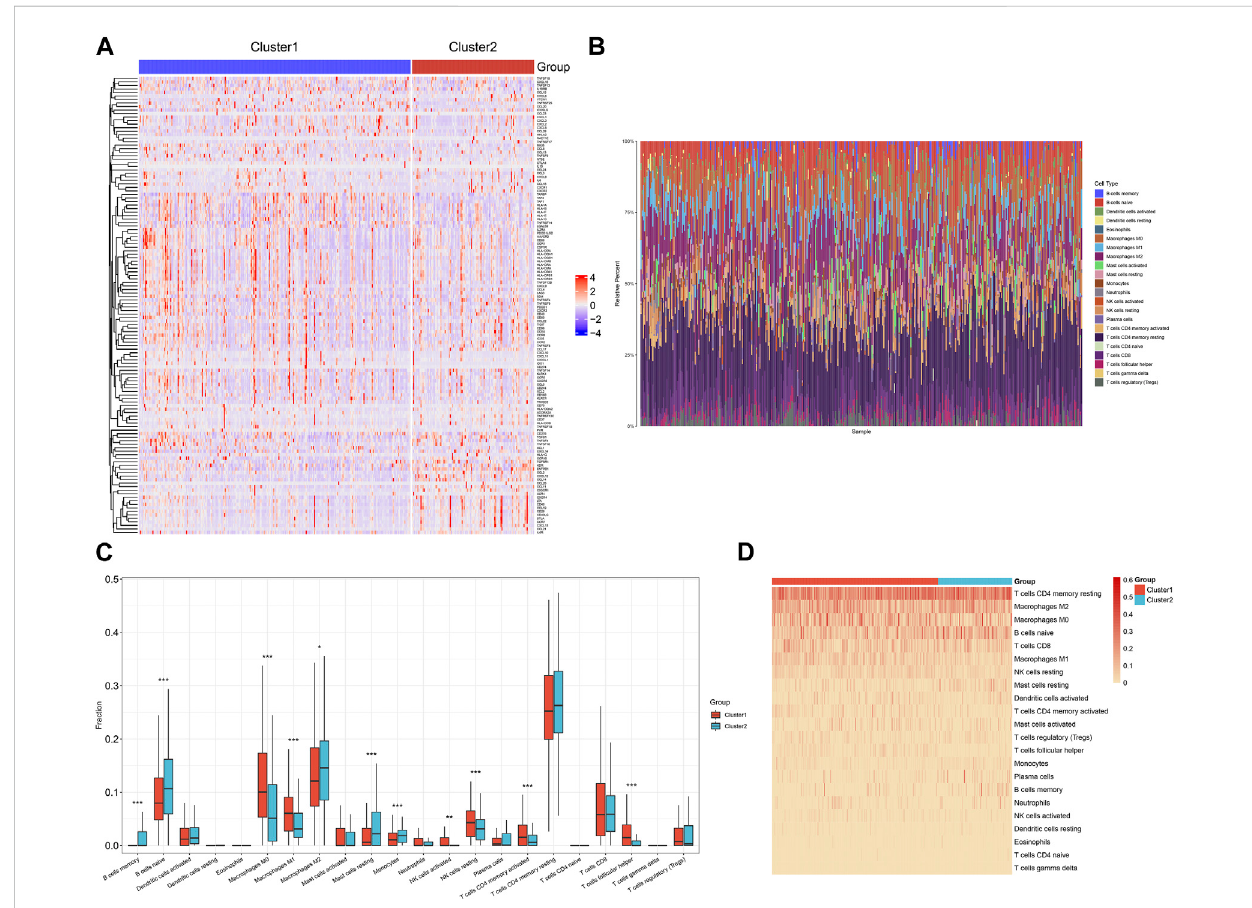
FIGURE 3 Tumor microenvironment heterogeneity across the two DNA damage repair-based subtypes in the TCGA-STAD cohort. (A) The transcriptional levels of immunomodulators across the two subtypes. Colors from blue to red denote low to high expression values of immunomodulators. (B) Landscape of the relative fractions of 22 immune cell types across TCGA-STAD. Each cell type is marked by unique color. (C) Comparison of the relative fractions of 22 immune cell types between subtypes. (D) The distribution of the relative fractions of 22 immune cell types across the two subtypes. The darker the color, the larger the relative fractions of immune cell